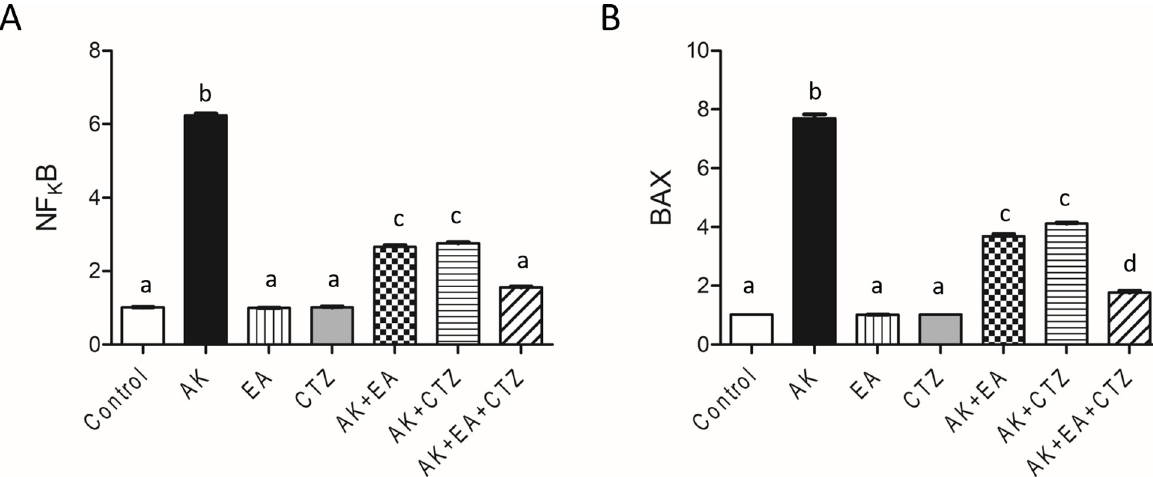
Fig 5. The effect of ellagic acid, cilostazol, and their combination on apoptotic markers. Quantitative analysis of Bcl-2 associated x protein (BAX) and nuclear factor kappa B (NF κ B) in renal tissue. Ellagic acid (EA) 10 mg/kg, cilostazol (CTZ) 10 mg/kg and their combination were administered one hour before intramuscular injection of amikacin 400 mg/kg for seven days. Groups were compared using one-way ANOVA and post-hoc Turkey ʼ s test. Values are presented as mean ± SE (n = 7). Values without common small letters are significantly different ( p < 0.05).